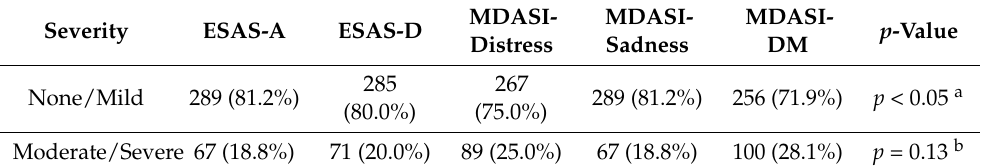
Table 2. Distress prevalence at baseline across ESAS-A, ESAS-D, MDASI-distress, MDASI-sadness, and MDASI depression-mood component score between 2014 to